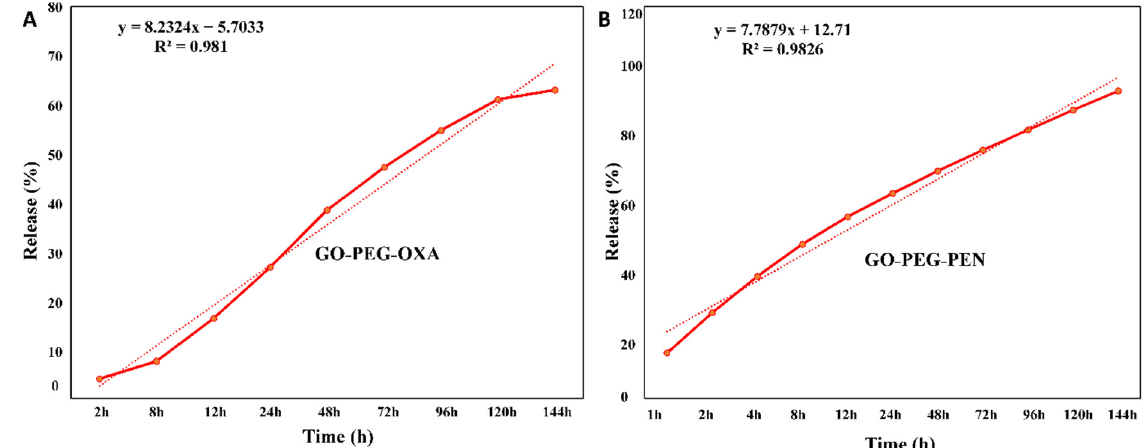
Figure 6. Release of antibiotics from GO-PEG; ( A ) GO-PEG-OXA, ( B )